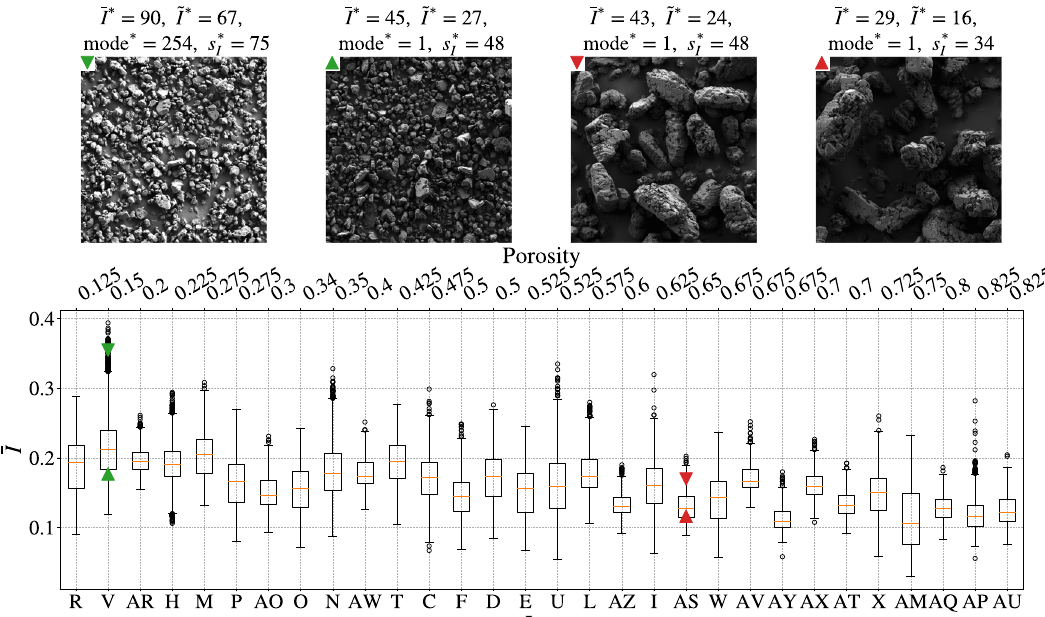
Fig. 2 Example SEM images and box plot of image pixel intensity distributions within each lot. Image intensity measurements are shown above each example image. Asterisk superscript denotes a scaling up factor of 255. For example, I (cid:3) ¼ I ´ 255 , rounded to the nearest integer. I of each example image is indicated in the box plot using the corresponding image label (green and red triangles). Box plot central lines indicate medians. The boxes extend from Q1 to Q3 quartiles of the data. Whiskers extend from box edges to the farthest data point within 1.5 interquartile range. Further data points are considered as outliers and are plotted